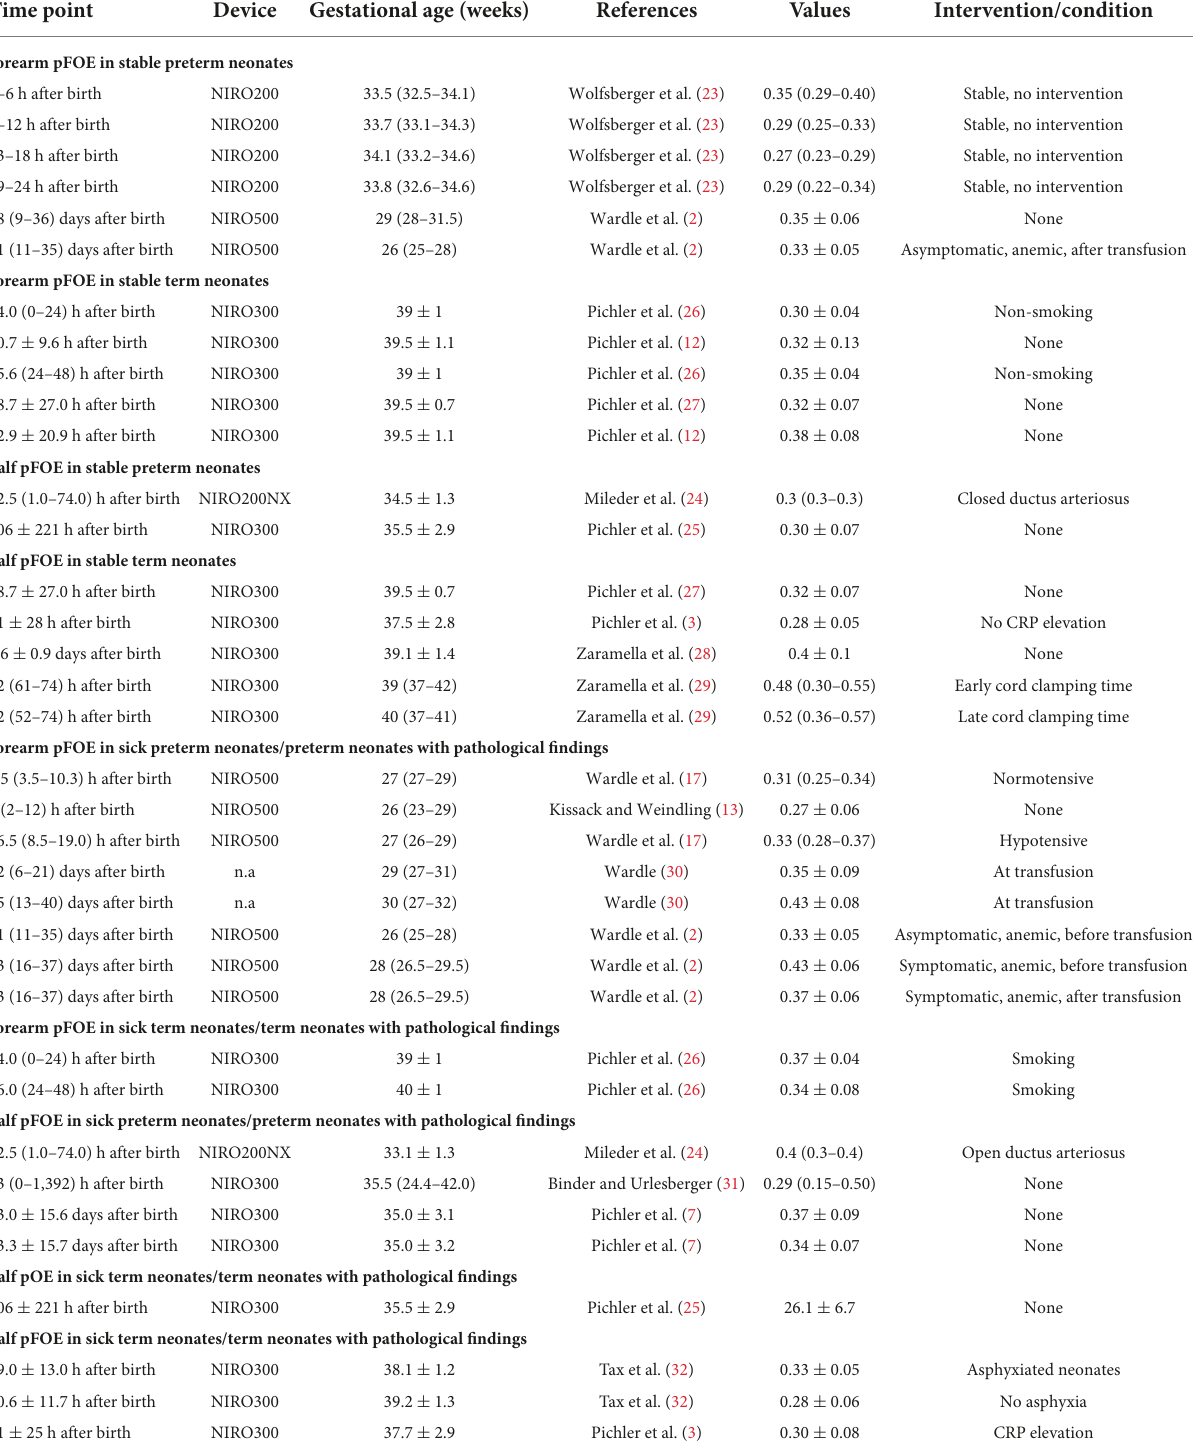
TABLE 2 pFOE and pOE in preterm and term neonates with peripheral muscle NIRS measurements on the forearm and calf, sorted according to the mean/median time point after birth when NIRS measurements were performed. Time point